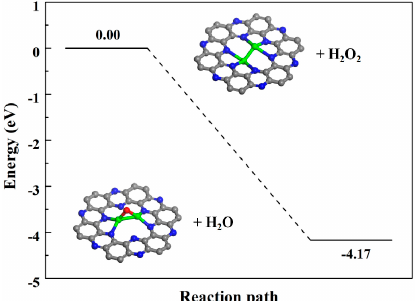
Figure 2. Transformation process of a Fe 2 dimer in H 2 O 2 solution. The inset was the atomic structure model of each step.